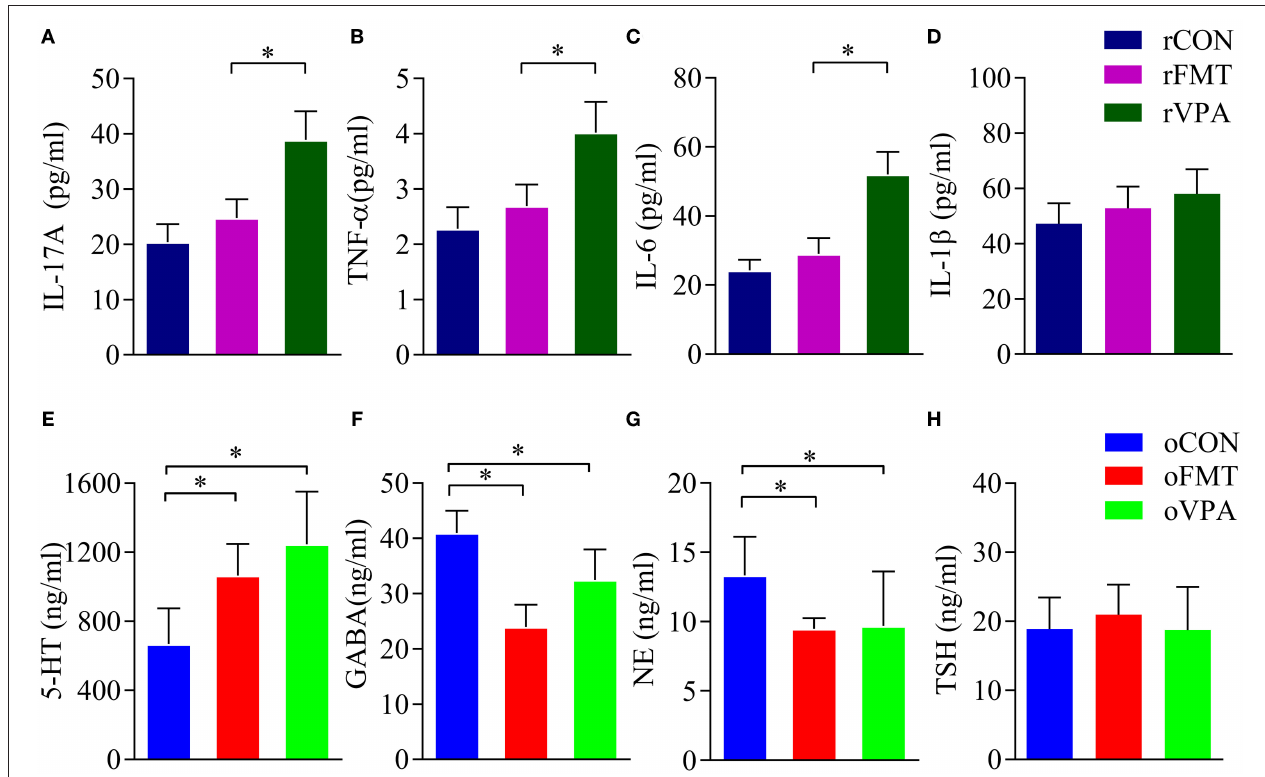
FIGURE 3 | Impact of FMT on serum factor in pregnant and offspring rats. (A–D) Serum factor index of pregnant rats. (E–H) Serum factor index of offspring rats. Data presented as mean ± SD. Data processing was performed using IBM SPSS Statistics 22.0, and statistical significance was established at * P < 0.05 (red: oFMT; green: oVPA; blue: